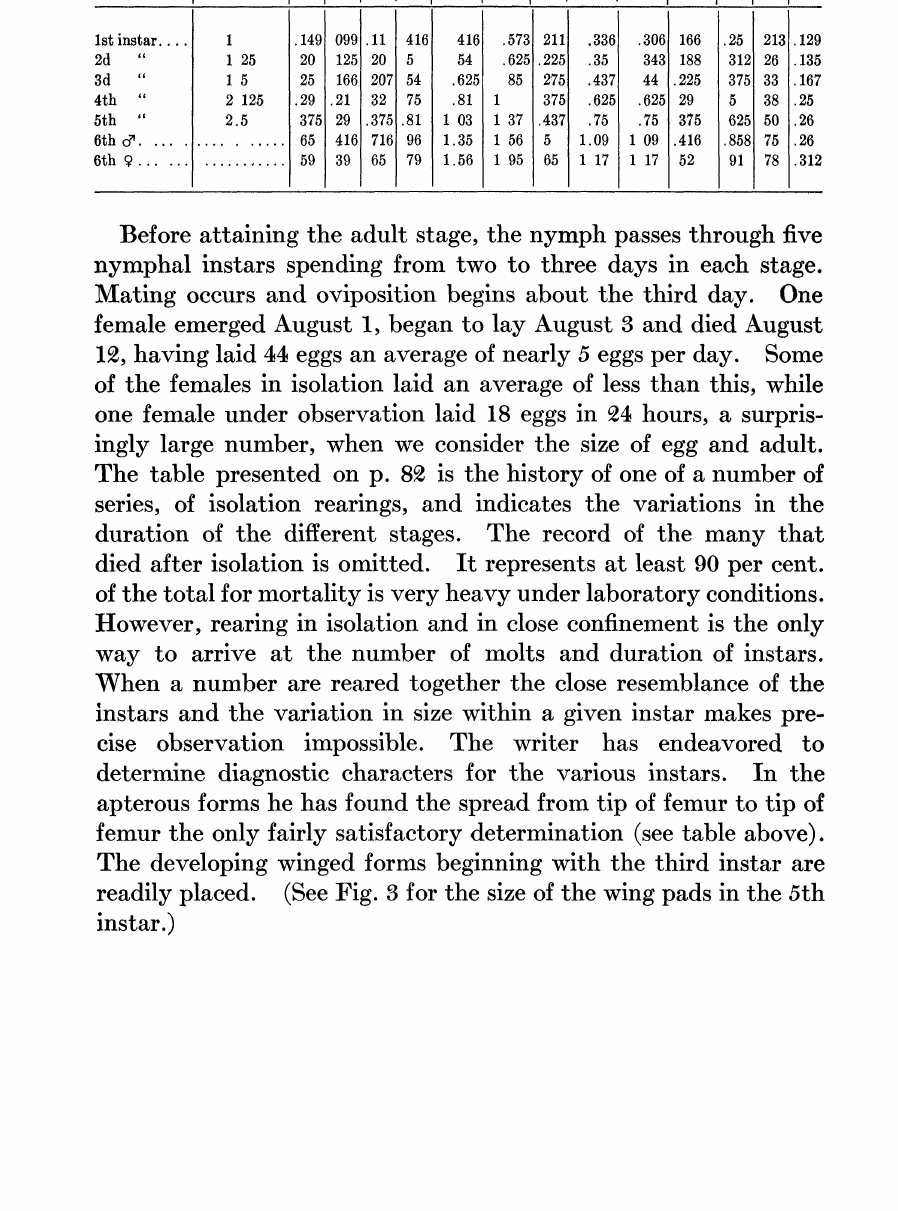
TABLE OF MEASUREMENTS IN MILLIMETERS OF INSTARS OF MESOVELIA MULSANTI.